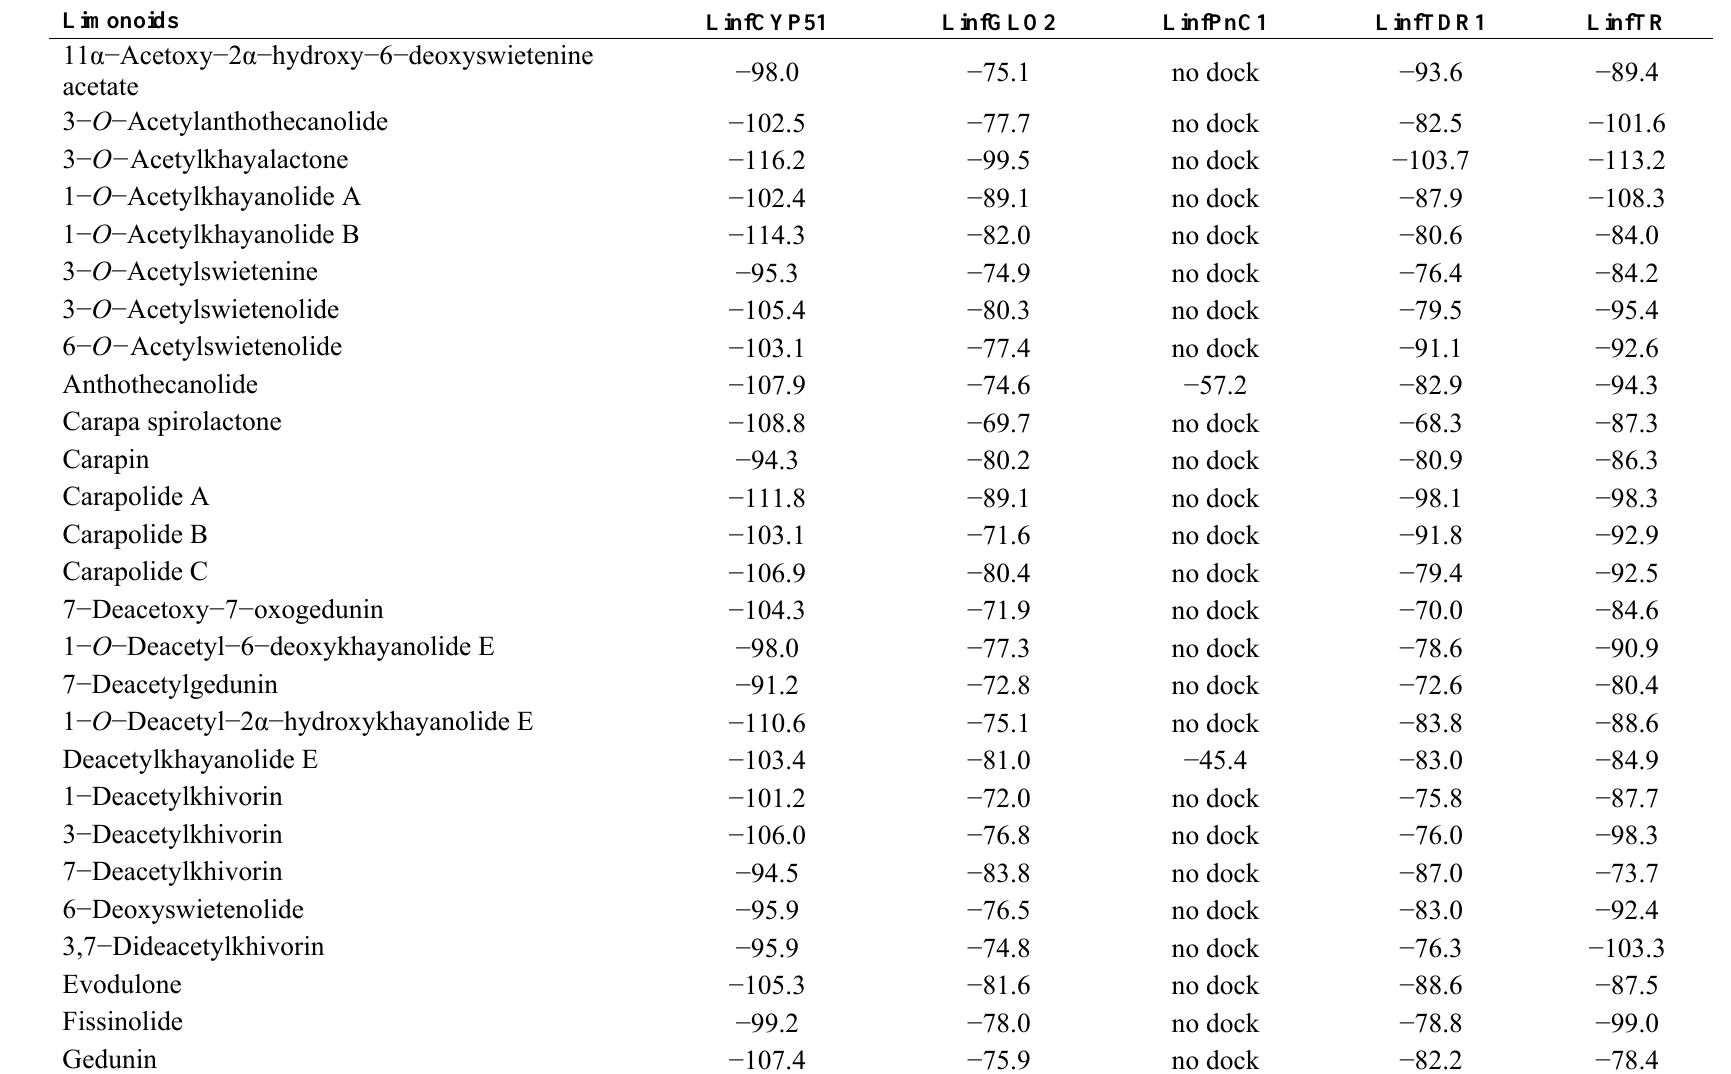
Table 31. MolDock docking energies (kJ/mol) of limonoids with Leishmania infantum protein targets.